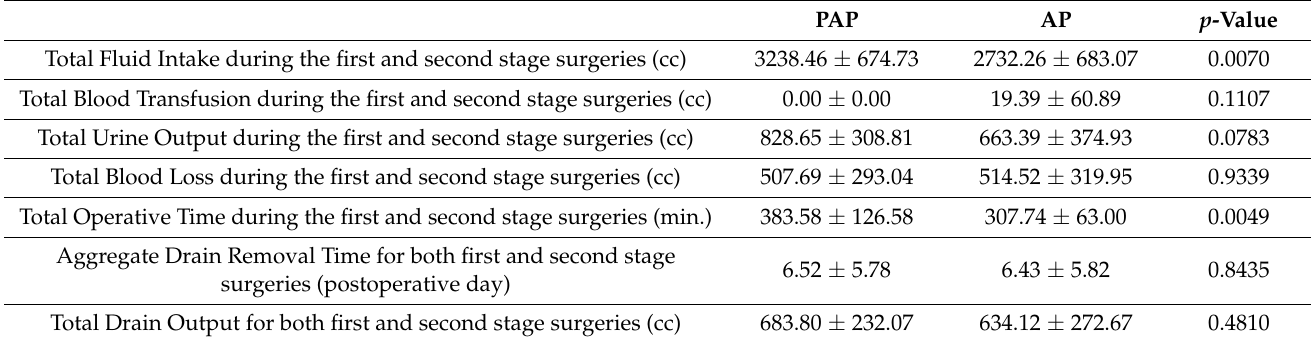
Table 2. Surgical profiles of staged AP and PAP patients.